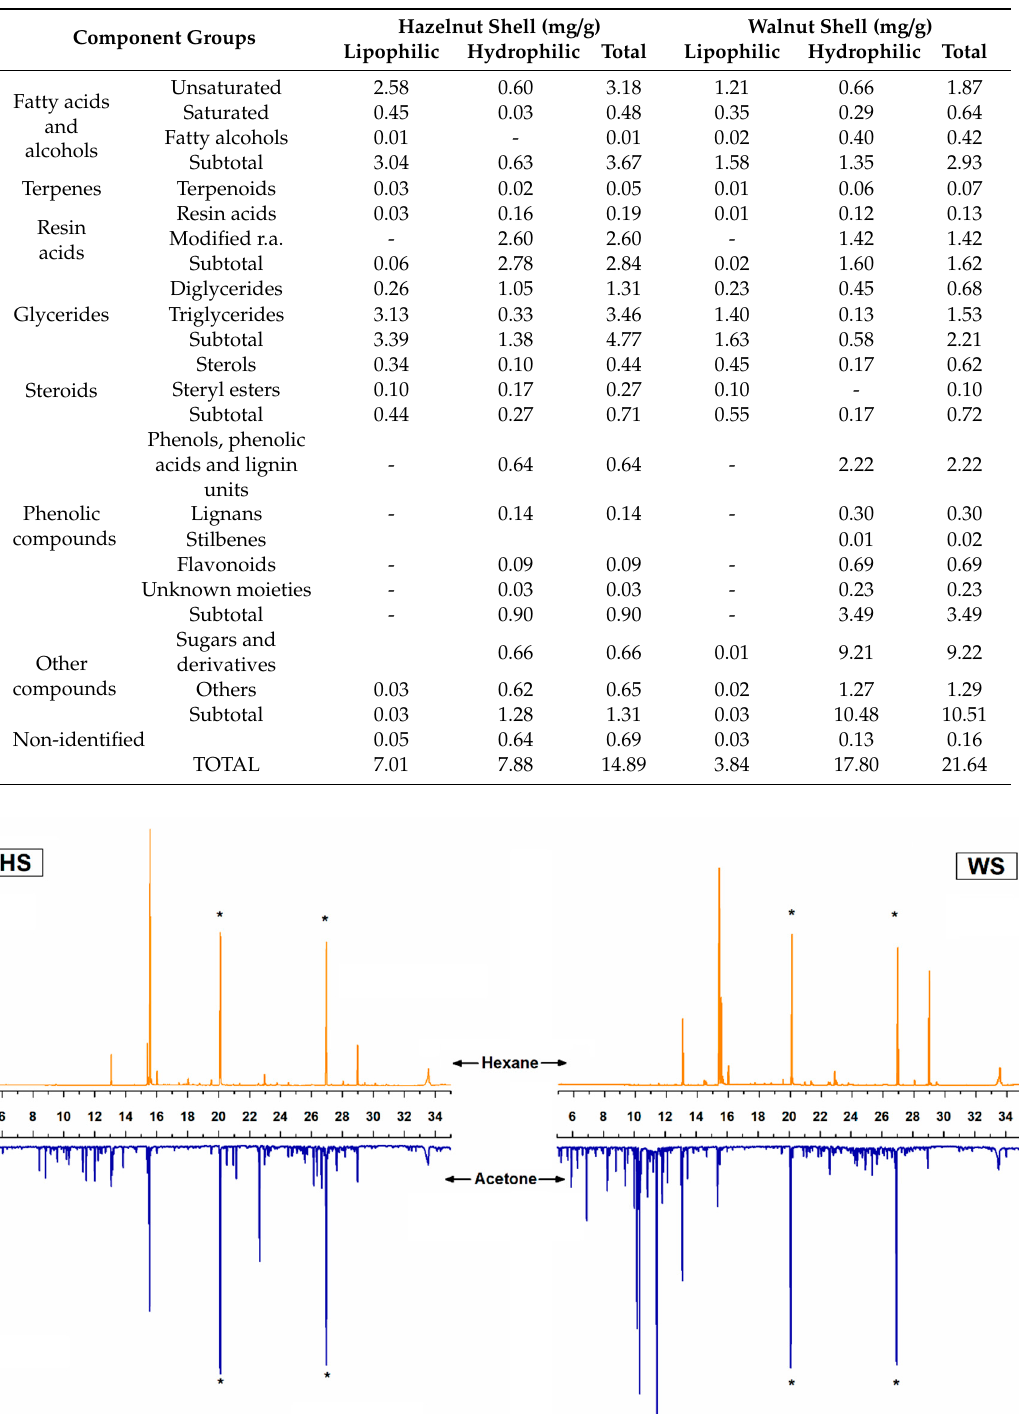
Table 2. Groups of components present in the fractions (lipophilic and polar) of HS and WS determined by gas chromatography (GC) and GC-mass spectroscopy (GC-MS).